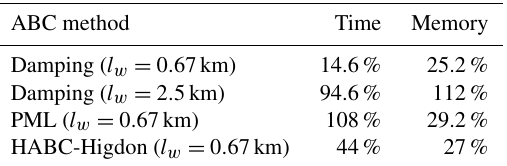
Table 4. The percent growth of the wall clock time and RAM usage, as compared to the no-ABC case ( l w = 0 . 0km). The measures are related to a source of a single shot wave of the FWI execution for the velocity model that is matched with Marmousi. In this case, the execution of FWI with no-ABC required 75s of wall clock time and 5GB of memory